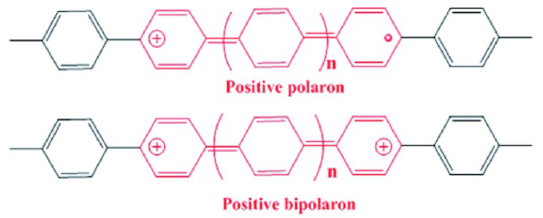
Table 1. The components used for the preparation of the polyaniline/zinc oxide (PANI/ZnO) composite